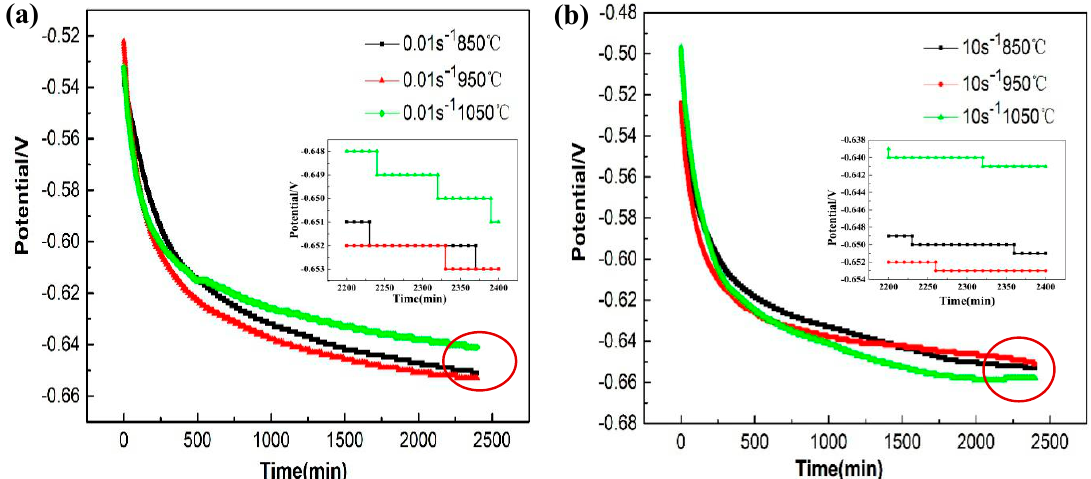
Figure 4. The open-circuit potential (OCP) curves of 35CrMoV steel in 3.5 wt% NaCl solution: ( a ) 0.01 s − 1 , 850–1050 °C; ( b ) 10 s − 1 , 850–1050 °C.